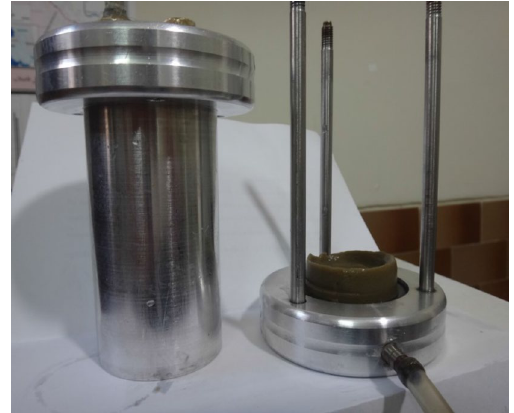
2 -MWCNTs membrane